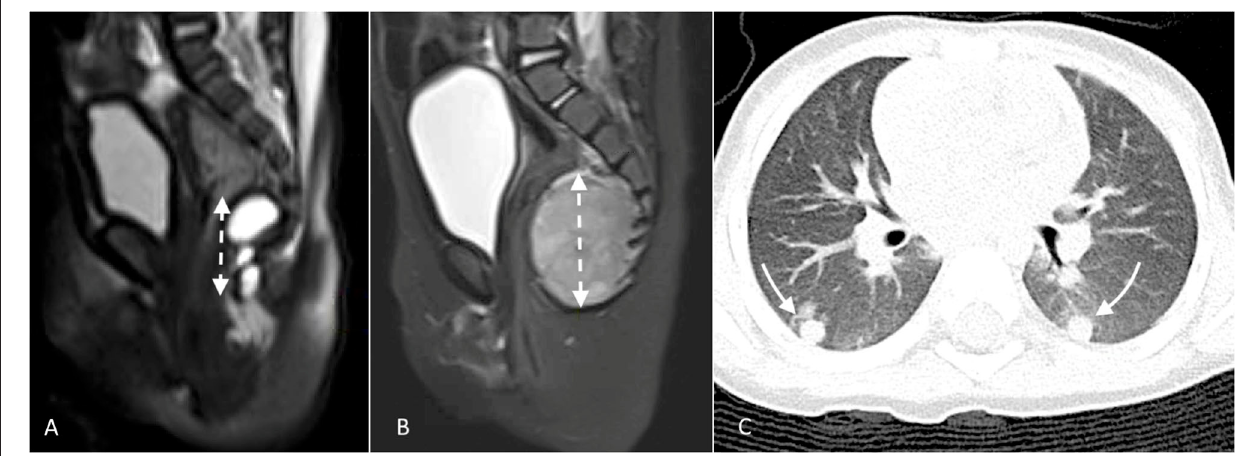
FIGURE 1 | Select images from Case 1: (A) Initial MRI demonstrating lobulated cystic mass which on pathologic exam post-resection was mature cystic teratoma; (B) MRI 8 months later demonstrating pre-sacral, solid tumor recurrence; and (C) CT scan showing simultaneous, bilateral lung metastases which biopsy confirmed to be malignant teratoma (yolk sac